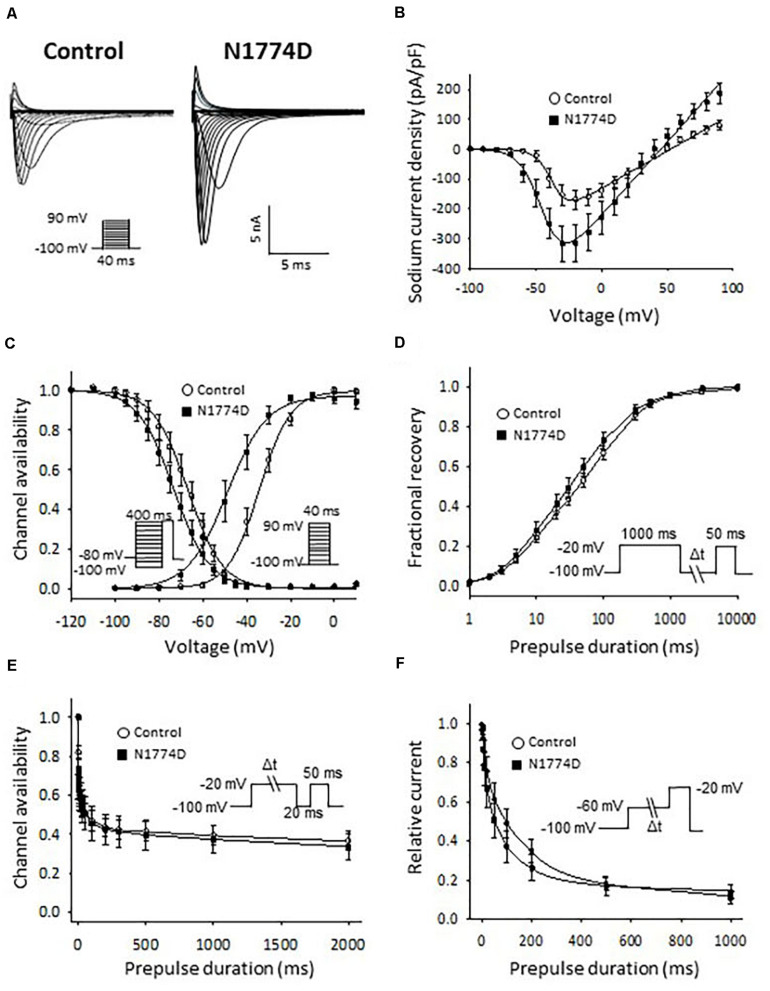
Sodium current recordings and gating properties of sodium channels in hiPSC-CMs. (A) Representative traces of sodium currents in control and N1774D-hiPSC-CMs. The pulse protocol is shown in the inset. (B) Average current-voltage relationship for peak sodium current in control (n = 15, open circles) and N1774D channels (n = 15, closed squares). Data were fitted with the Boltzmann equation (see “Materials and Methods”). The currents were normalized to the cell capacitance to give a measure of peak current densities. The peak current densities were significantly lager in N1774D. (C) Voltage dependence of steady-state inactivation and activation in control and N1774D-hiPSC-CMs. Curves were fit using the Boltzmann equation. The activation curve negatively shifted by 13 mV. (D) Time course of recovery from inactivation was obtained by a double pulse potential shown in inset. Experimental data were fit to a biexponential. (E) Onset of slow inactivation. Time course of entry into the slow inactivation state was measured by a double pulse protocol shown in inset. Curves were fit with a shingle exponential equation. (F) Closed-state inactivation. The transfer rate of sodium channels from closed-state to inactivated closed-state without an intervening opening state was elicited with a double pulse protocol shown in inset. The data pooled from different lines or clones among the control and N1774D group were analyzed.